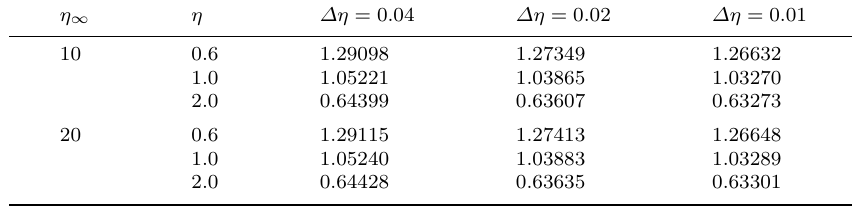
Table 7. Grid-invariance test for concentration profile.